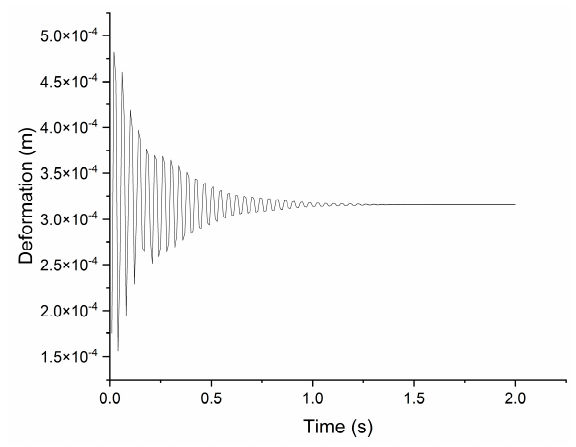
Figure 6. Transient analysis result.